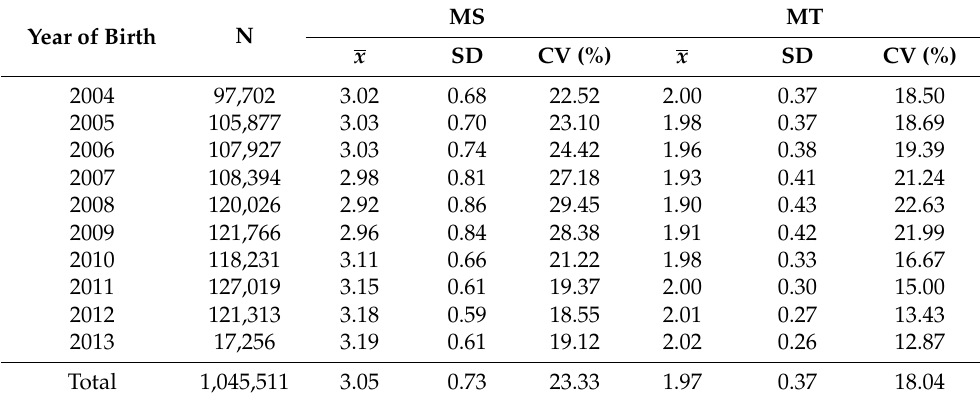
Table 4. Number (N), means ( x ) and standard deviations (SD) of workability traits in Polish Holstein- Friesian cattle population by the year of birth.